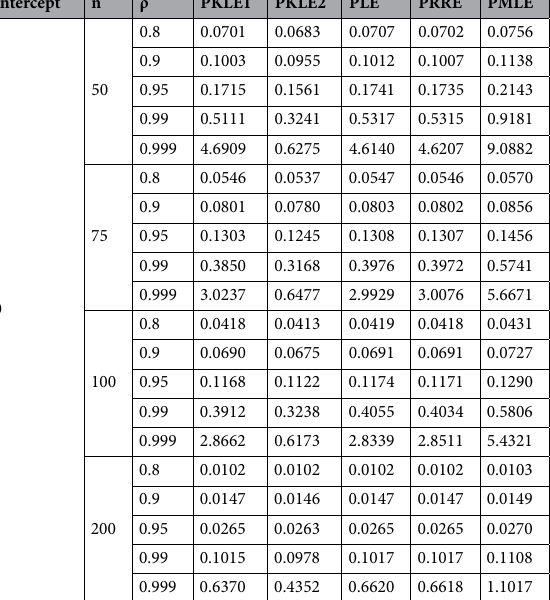
Table 2. Simulated MSE when p = 4 and intercept =